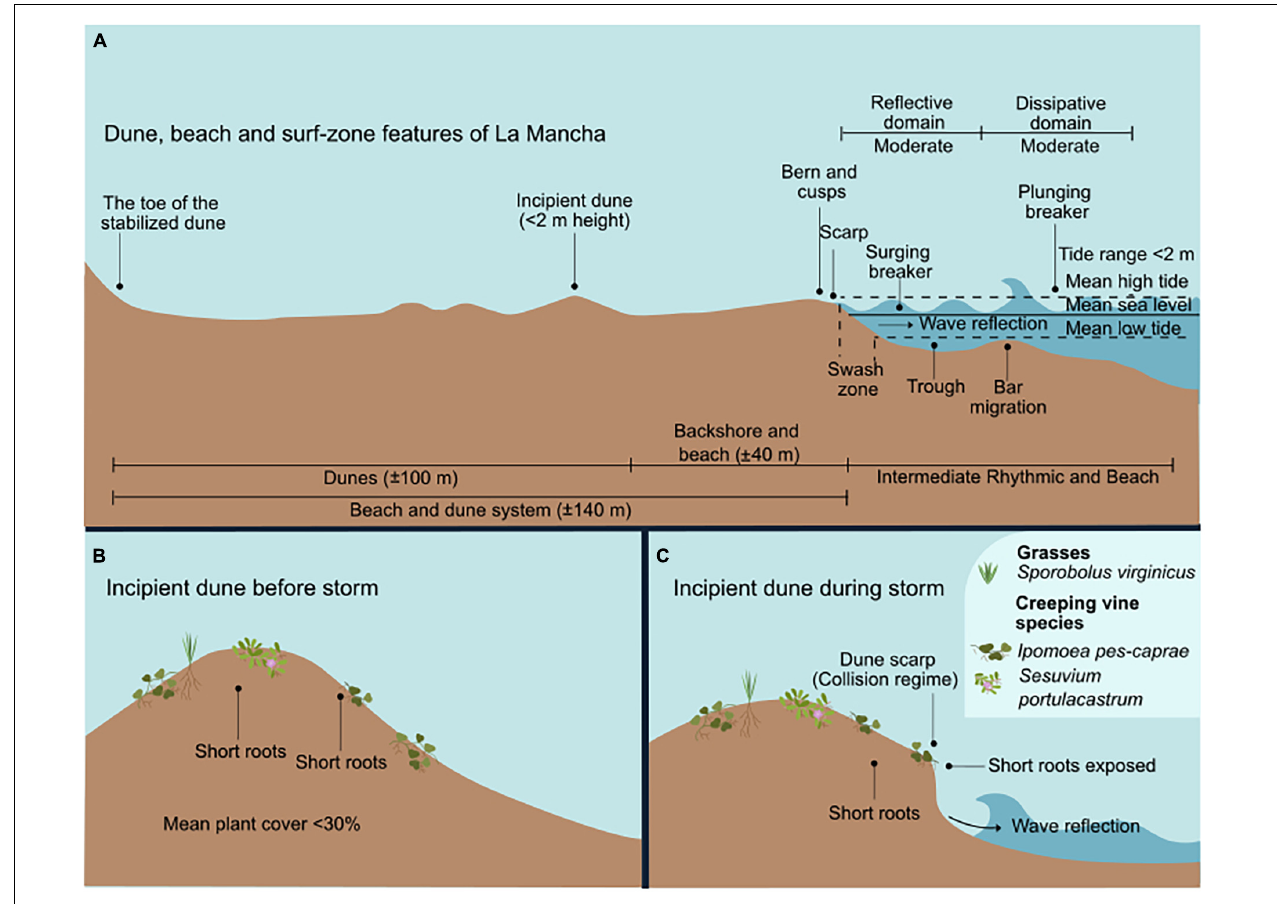
FIGURE 6 | The surf-zone and dunes of La Mancha. (A) Dune, beach, and surf-zone features. (B) The incipient dunes and species before the storm. (C) The incipient dunes during the storm, showing the wave-induced